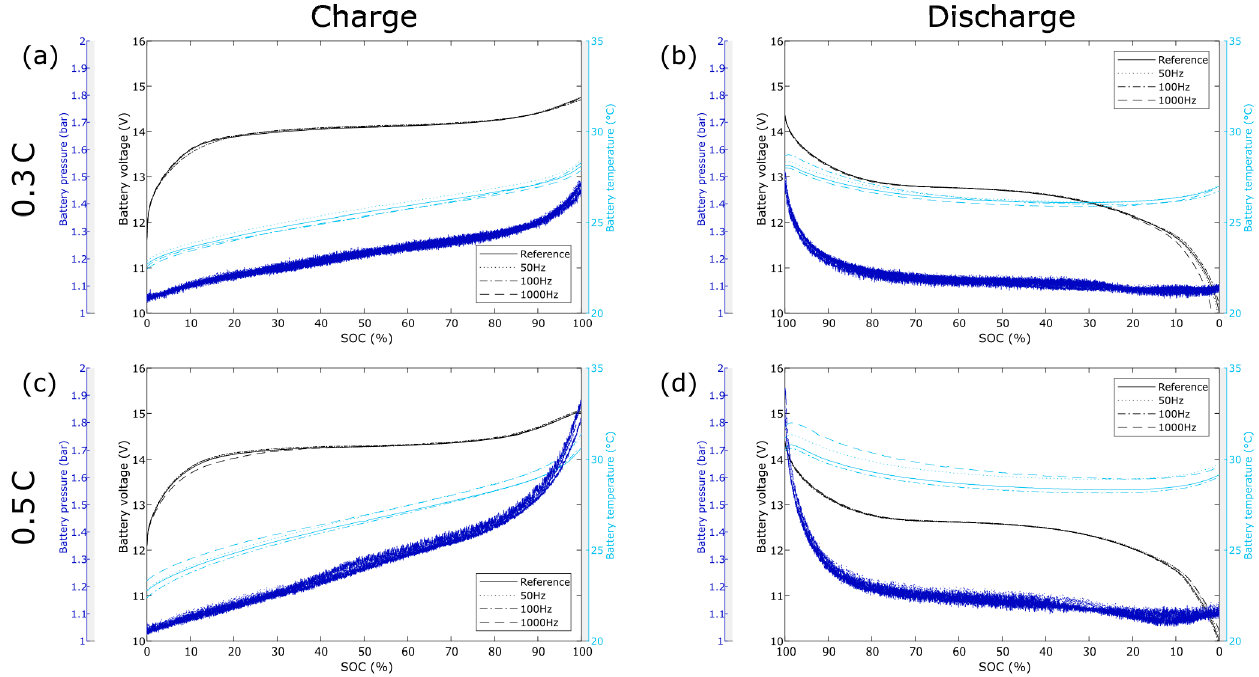
Figure 2. NiMH battery voltage, temperature, and absolute gas pressure vs. State of Charge (SOC) for different overlay frequencies. The sinusoidal AC-amplitude is 70% of the C-rate. Ambient temperature: 22 ± 1 °C. ( a ) Charge 0.3 C; ( b ) Discharge 0.3 C; ( c ) Charge 0.5 C; ( d ) Discharge 0.5 C.